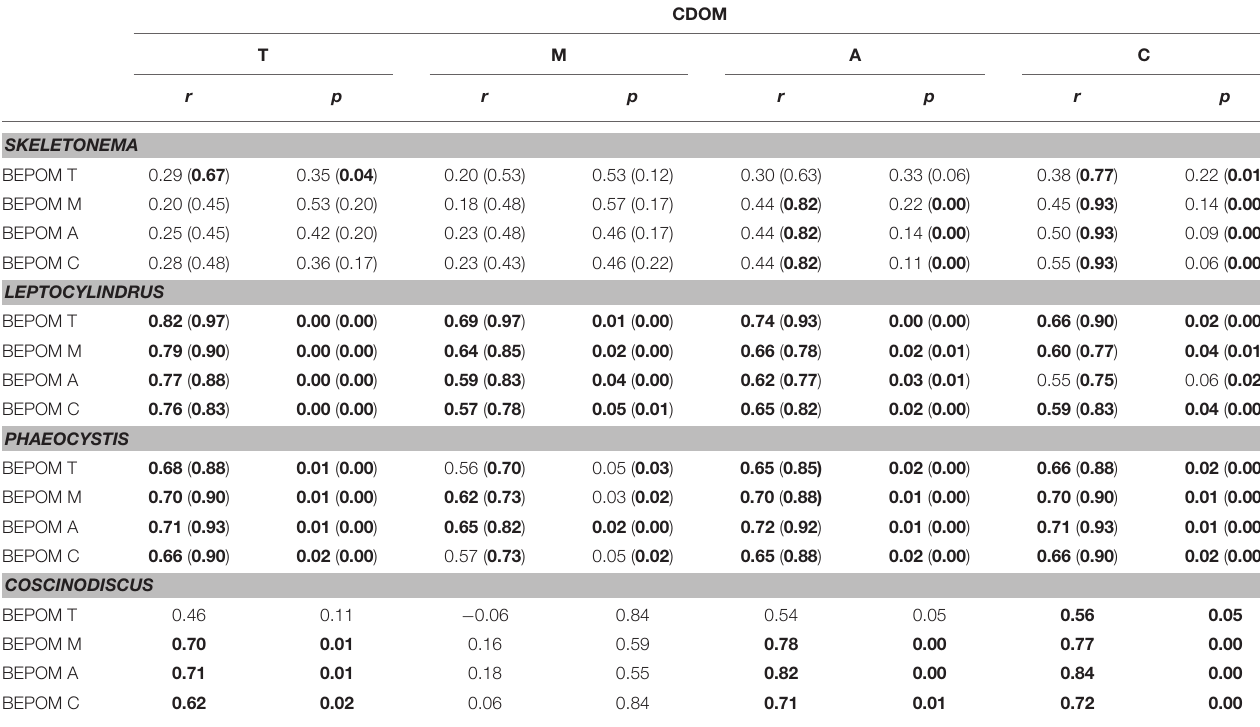
TABLE 2 | Spearman correlation coefficient ( r ) between select CDOM fluorescence peaks and select BEPOM fluorescence peaks (T, M, A, and C) for all data ( n = 12) and excluding degradation phase data in parenthesis ( n = 9).